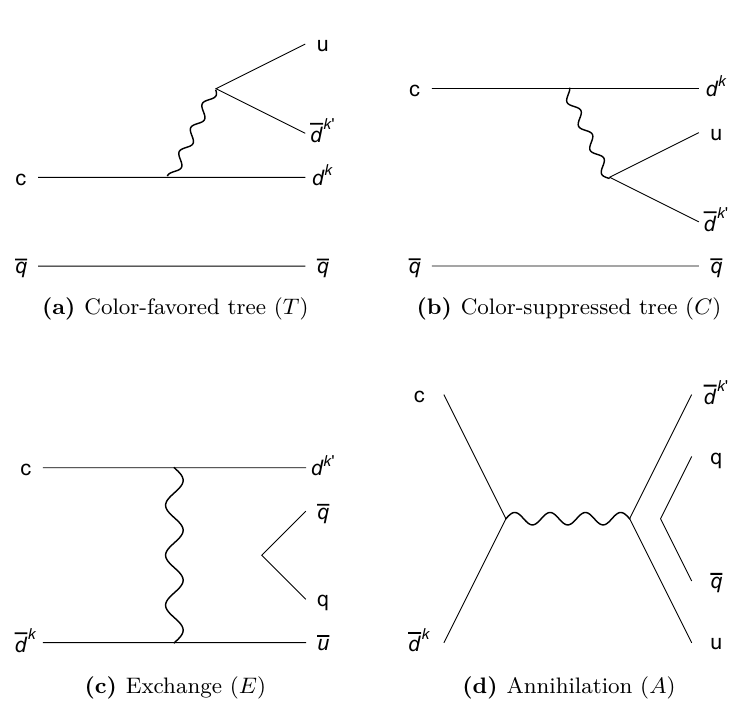
Figure 1. Topological flavor-flow diagrams used to describe CF D → PP decays.